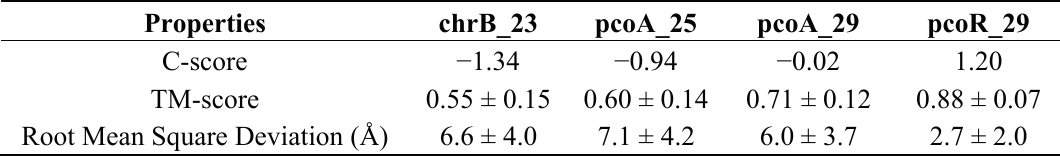
Figure 8. Shows the predicted structures of ( a ) chrB_23 ( b ) pcoA_25 ( c ) pcoA_29 and ( d ) pcoR_29 using I-TASSER. The models show the structure of the proteins using the following annotations: helices in magenta, sheets in yellow, turns in light blue and all the other residues in white. Table 2. Statistical analysis of predicted I-TASSER